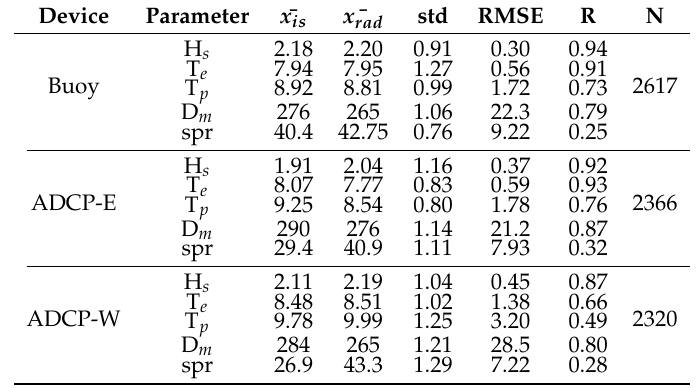
Table 1. Summary statistics of the radar and in situ H s , T e , D m and directional spread comparisons calculated over the full range of frequencies (0.05–0.25 Hz), as shown in Figure 4d. The third and fourth columns are the in situ- and radar-measured mean values, respectively. The fifth column is the radar standard deviation normalized by the in situ value, the sixth is the RMSE (meters, seconds and degrees for H s , T e , D m , and spr, respectively), the seventh is the correlation coefficient, and the last column is the number of